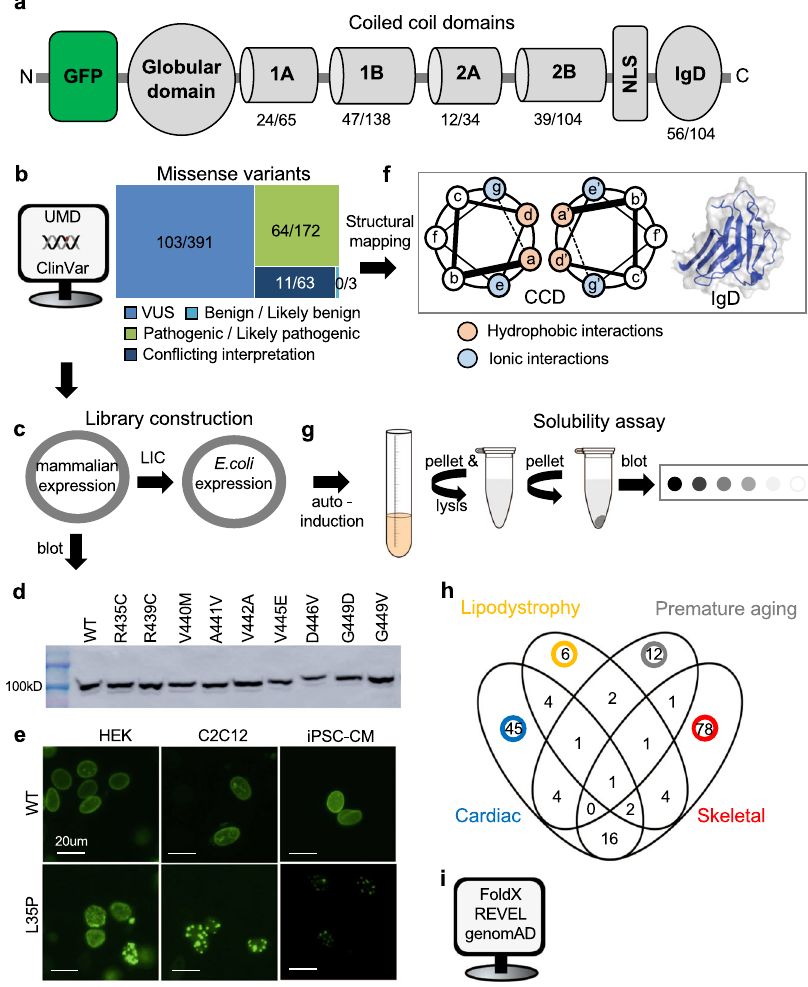
Fig. 1 Lamin characterization work fl ow. a Schematic of lamin A showing each structural domain and locations of the GFP tag and NLS. Numbers indicate the number of missense variants from Universal Mutational Database studied herein/total number of missense variants in ClinVar (and UMD) for indicated domains. b Sequence variants grouped by their clinical signi fi cance are described in ClinVar (linker variants not included). Numbers for each category indicate the number of missense variants we studied/total number of missense variants reported in ClinVar as of July 2021. c Variant library construction. d Representative western blots of full-length lamin A expressed in HEK 293 cells (lamin A (74kD) + GFP (27kD) = 101kD). e Representative images (20 μ m scale bar) of L35P nuclear aggregation compared to WT for the three cell types used. f Mapping of the variants to the IgD structure and CCD locations (pink and blue indicate hydrophobic and ionic dimerization interacting residues, respectively and gray indicates variable surface residues. g Solubility (i.e., stability) assay described previously 22 . h Venn diagram showing disease classi fi cation for all disease-linked variants studied. i In silico tools used to compare to lamin A variant aggregation results. GFP green fl uorescent protein, NLS nuclear localization signal, IgD immunoglobin-like domain, UMD, Universal Mutational Database, VUS variants of uncertain signi fi cance, CCD coiled-coil domain, LIC ligation-independent subcloning, HEK human embryonic kidney cells, mouse myoblasts (C2C12), iPSC-CMs induced pluripotent stem cell-induced cardiomyocytes, REVEL Rare Exome Ensemble Learner, genomAD Genome Aggregation